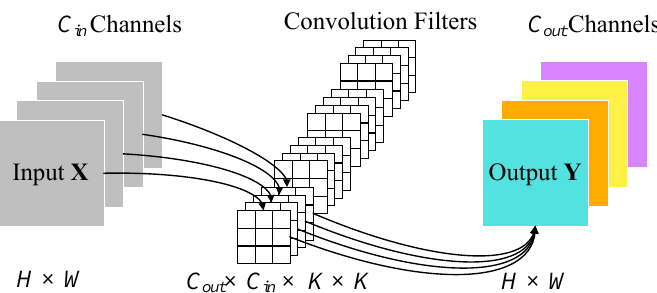
Figure 3. Illustration of standard convolution.